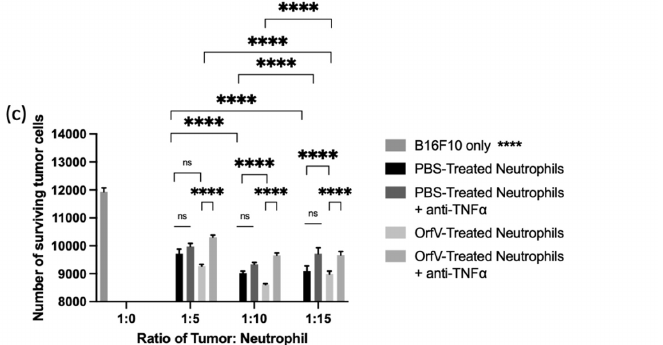
Figure 3. OrfV-stimulated neutrophils exhibited enhanced tumor necrosis factor (TNF)- ɑ -mediated cytotoxicity against tumor cells: ( a ) naïve seven- to nine-week-old female C57BL/6 mice ( n = 8 per group) were injected intraperitoneally with phosphate-buffered saline (PBS) or 5 × 10 7 PFU of OrfV. Two hours following treatment, bone marrow was flushed from femurs to isolate viable neutrophils (defined by a CD45 + Ly6G hi CD11b hi phenotype) by flow cytometric cell sorting. Neutrophils were co-cultured in vitro with B16F10 melanoma cells at increasing tumor-to-neutrophil ratios for 16 h. The viability of tumor cells was quantified via flow cytometry; ( b ) twenty-four hours after intravenous treatment with OrfV or PBS, B16F10 metastasis-bearing lungs were collected from the mice, and the cytokine response of immature and mature neutrophils (defined by CD101 expression) was quantified with flow cytometry after intracellular cytokine staining. TNF- α , tumor necrosis factor-alpha; IL-10, interleukin 10; IL-17A, interleukin 17A, IFN γ , interferon-gamma; PD-1, programmed cell death protein 1; IL-12p40, interleukin 12p40; IL-6, interleukin 6; ( c ) two hours after treating mice with OrfV, bone marrow-derived neutrophils (CD45 + Ly6G hi CD11b hi ) were flow-sorted. The isolated neutrophils were incubated with TNF- A -neutralizing antibodies and co-cultured in vitro with B16F10 melanoma cells at increasing tumor-to-neutrophil ratios for 16 h. The cell viability of tumor cells was quantified with flow cytometry. Statistical analysis was performed using two-way analysis of variance. Statistical significance was designated as * p ≤ 0.05, *** p ≤ 0.001, and **** p ≤